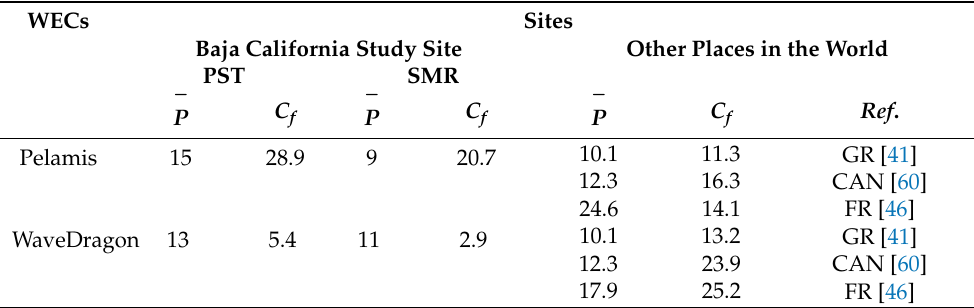
Table 3. Wave resource availability and productivity generated individually by Pelamis and Wave- Dragon in Baja California and other well-known places in the